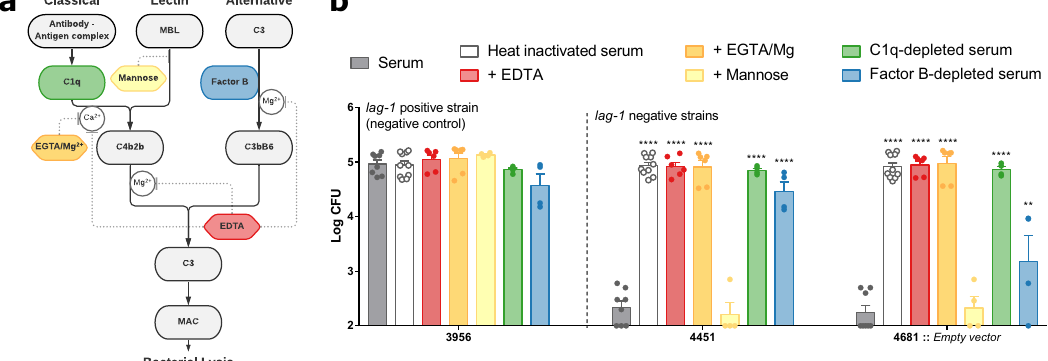
Fig. 6 The classical pathway is essential for complement-mediated killing of L. pneumophila . a Simpli fi ed schematic representation of the complement pathways and the inhibitors used in this study. Made using Lucidchart. b Inhibition of both classical and alternative pathways confers L. pneumophila resistance to complement killing in human serum. 3956, 4451, 4681:: Empty vector isolates were incubated with 90% heat-inactivated serum, serum, serum with EDTA, EGTA/Mg 2 + or mannose, Factor B- or C1q-depleted serum for a 1 h at 37 °C. Each point represents an average of three technical replicates for a single biological replicate ( n = 8 biological replicates for heat-inactivated serum and serum; n = 6 for serum with EDTA and with EGTA/Mg; n = 4 for serum with Manose, Factor B- and C1q-depleted serum). Statistical analysis when compared to serum on top of the bars. One-way ANOVA, Tukey ’ s multiple comparisons test, ** p < 0.01 **** p < 0.0001. Source data and exact p -values are provided in the Source Data fi